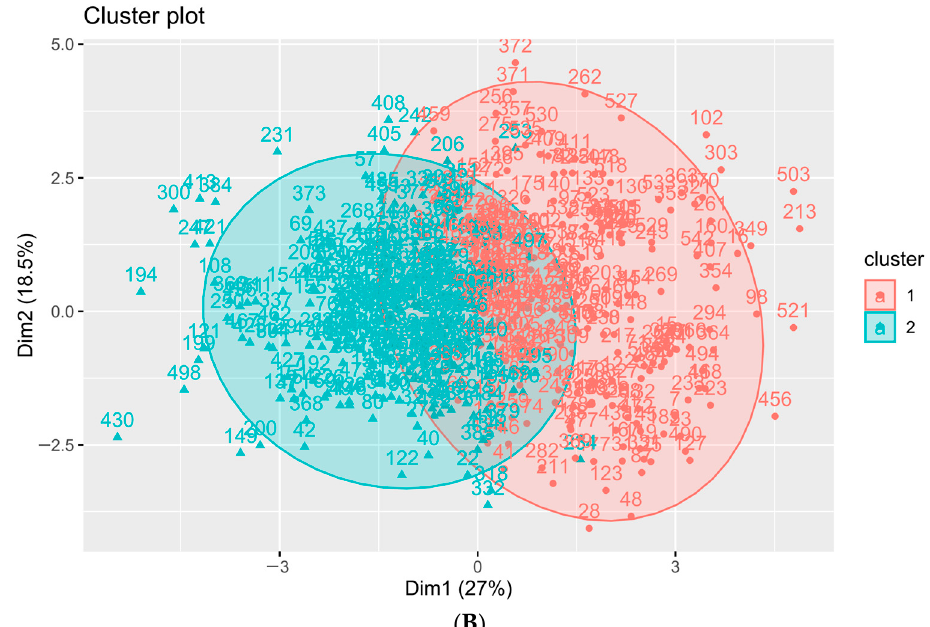
Figure 2. Clustering plots of the analyzed data. ( A ). Dendrogram of the bottom-up agglomerative clustering. Each leaf corresponds to one student. Students who are similar are combined into branches, which are fused at a higher height. The height of the fusion, provided on the vertical axis, indicates the (dis)similarity/distance between two students/clusters. The hierarchical tree was cut to partition the data into clusters (blue for Cluster 1 and red for Cluster 2). ( B ). Cluster plot of the k-Medoids analysis. Red for Cluster 1 and blue for Cluster 2.